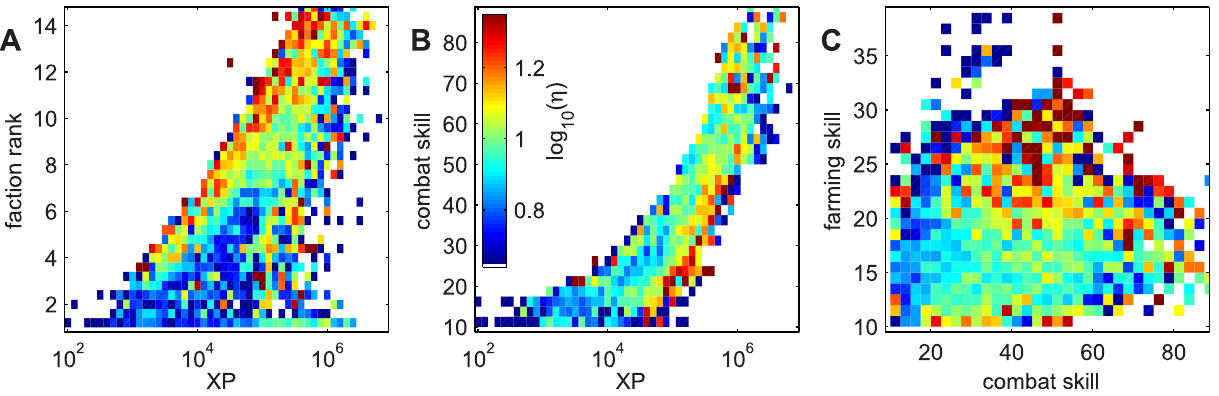
Figure 6. 2D binned averages of the wealth-gain as a function of achievement-factors. Colors represent the logarithm of the average wealth-gain, log 10 ( g ) , over all players that fall into that bin. Blue corresponds to low, red to high values, empty bins are white. A XP and faction rank, B XP and combat skill, C combat skill and farming skill. Data are taken every 240 days (see Methods). doi:10.1371/journal.pone.0103503.g006 PLOS ONE |